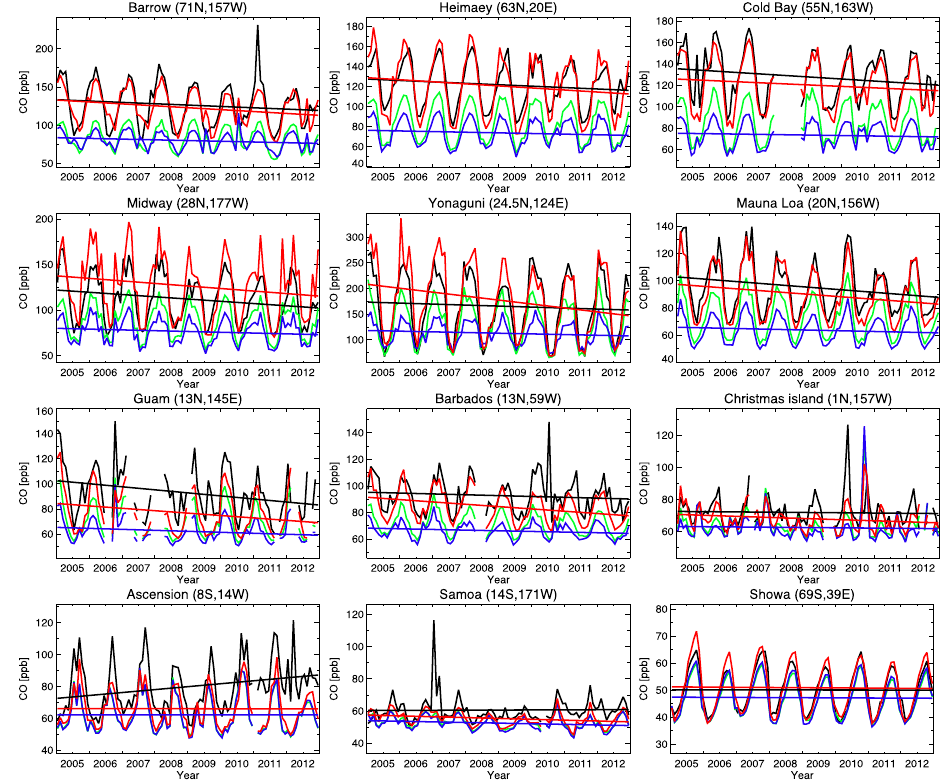
Figure 11. Time series of monthly mean CO concentration obtained from the WDCGG ground measurements (black), control run (blue), and reanalysis (red). Model simulation results with the HTAP emissions are also plotted (green).